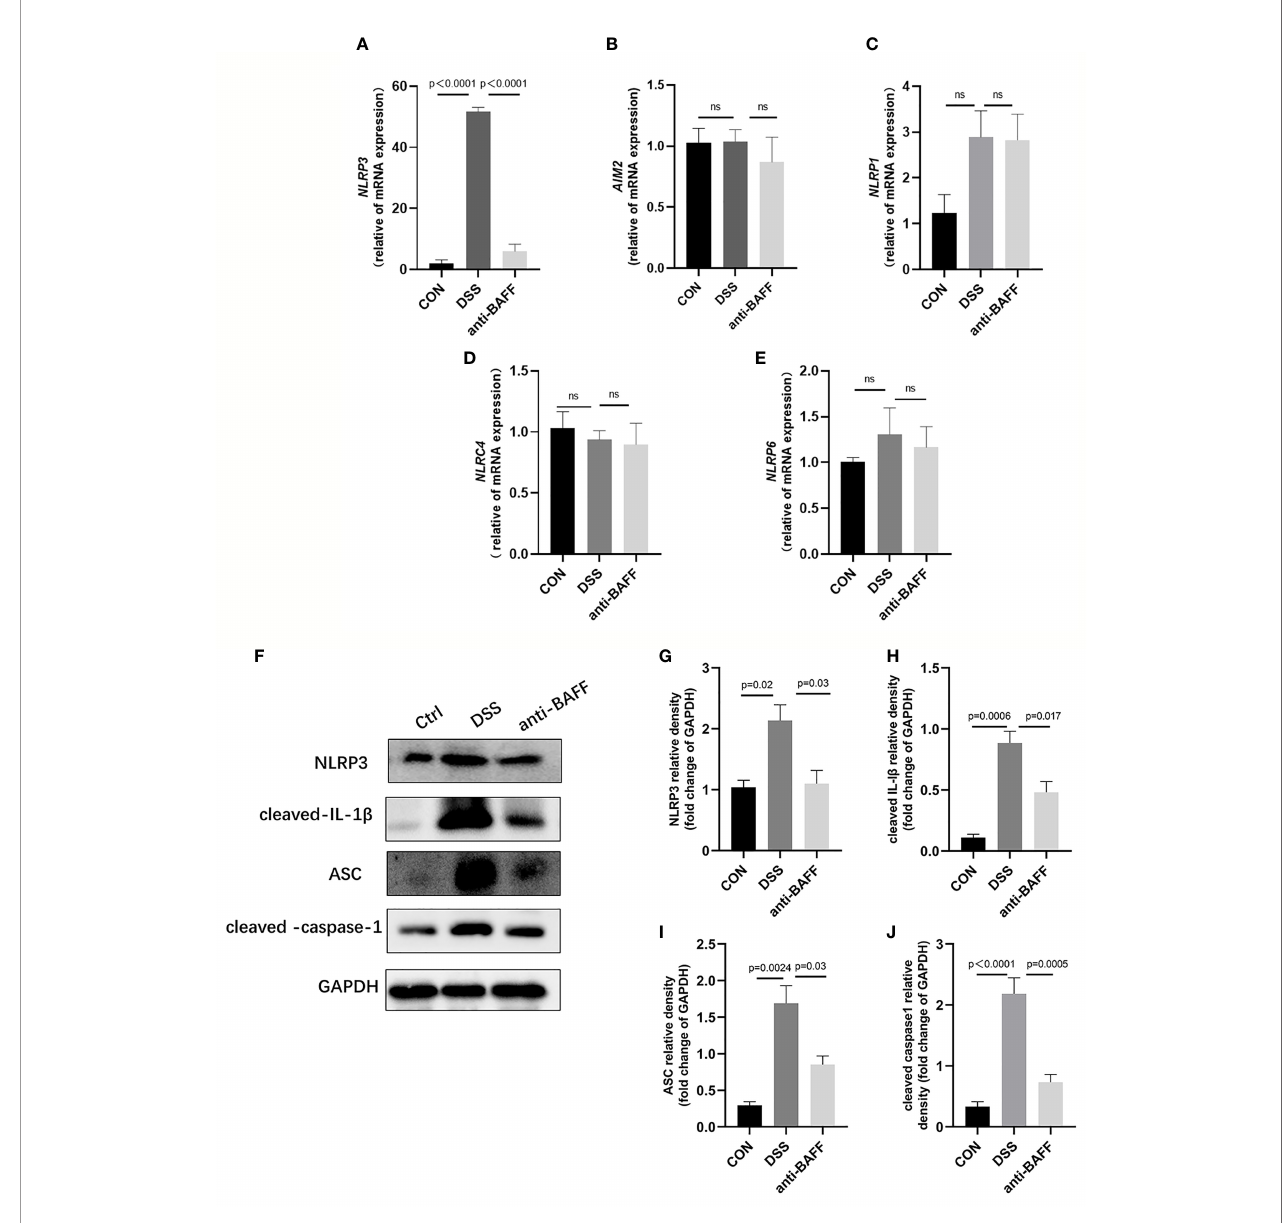
FIGURE 4 | Anti-BAFF antibody decreased colon level of NLRP3 in fl ammasome in DSS-induced experimental chronic colitis in mice. (A – E) Total mRNA was extracted from colonic samples to determine the mRNA expression of NLRP3, AIM2, NLRP1, NLRC4 and NLRP6 by RT-qPCR. (F) Representative immunoblot bands for the NLRP3, ASC, cleaved-IL-1 b and cleaved-caspase-1 proteins. GAPDH was used as a loading control. (G – J) Histogram of relative expression of NLRP3, ASC, cleaved-IL-1 b and cleaved-caspase-1 (n = 6 – 9 per group). NLRP3, NOD-like receptor protein 3, AIM2, absent in melanoma 2, NLRP1, NLR family, pyrin domain containing 1, NLRC4/IPAF, IL-1 b converting enzyme protease activating factor, NLRP6, NOD-like receptor family pyrin domain containing 6. ns, P > 0.05. Ctrl,